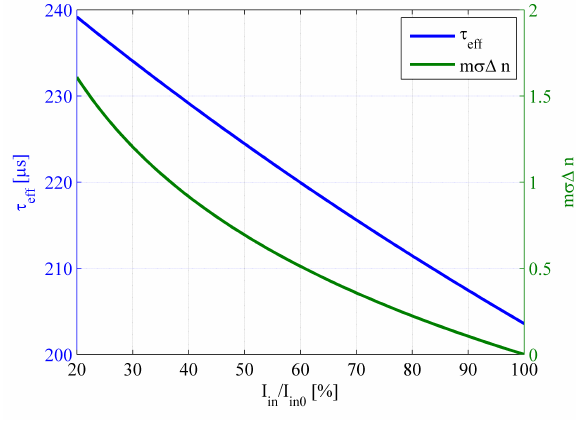
Figure 6. Theoretical change of τ